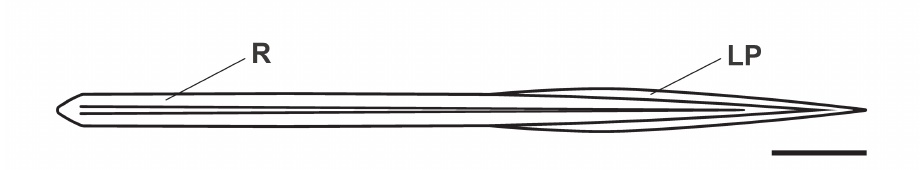
Fig. 4. Diagram of the gladius of Sepiola boletzkyi sp. nov., paratype, ♀, ESFM-CEP/1994-2 (anterior extremity on the left). Abbreviations: R = rachis, LP = lateral plate. Scale bar = 1 mm.